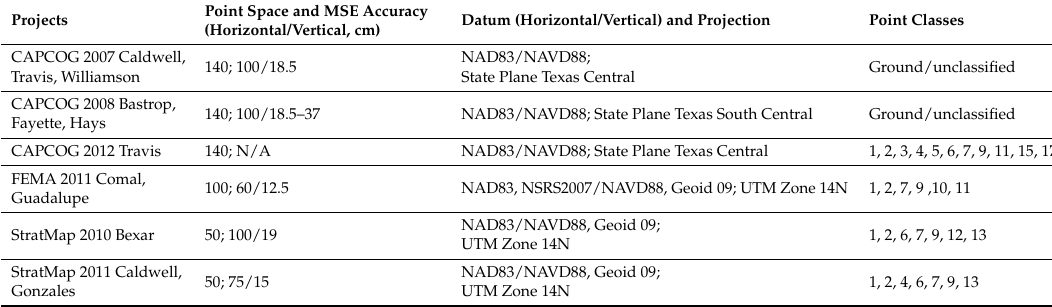
Table 2. Metadata of Lidar projects for the study